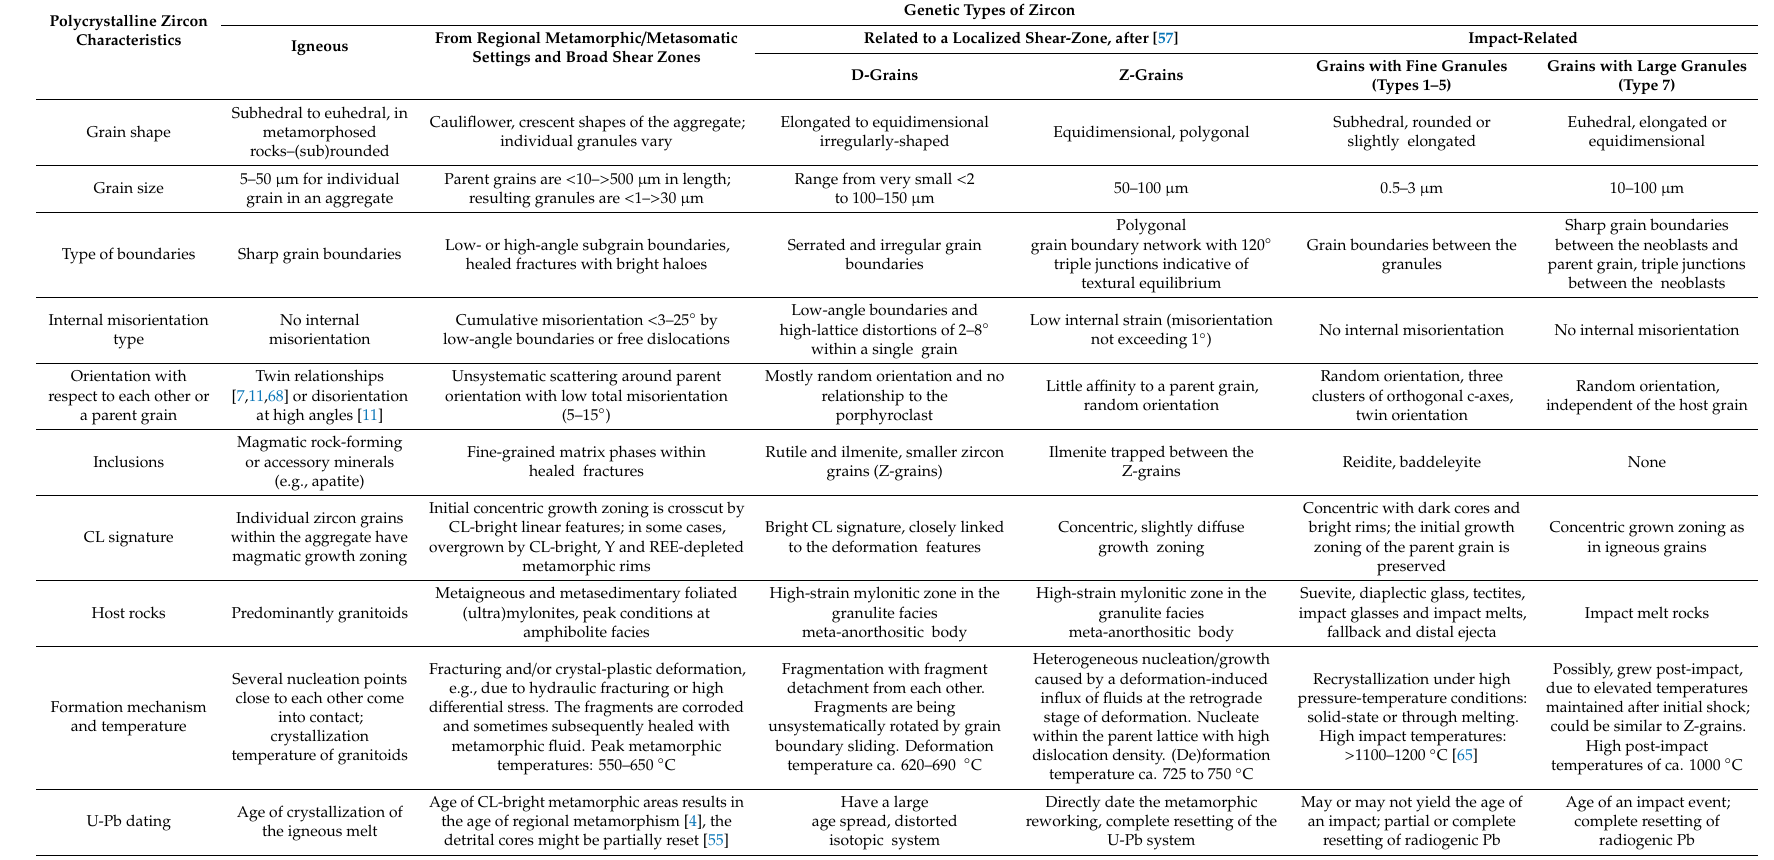
Table 1. Characteristics of various polycrystalline zircon